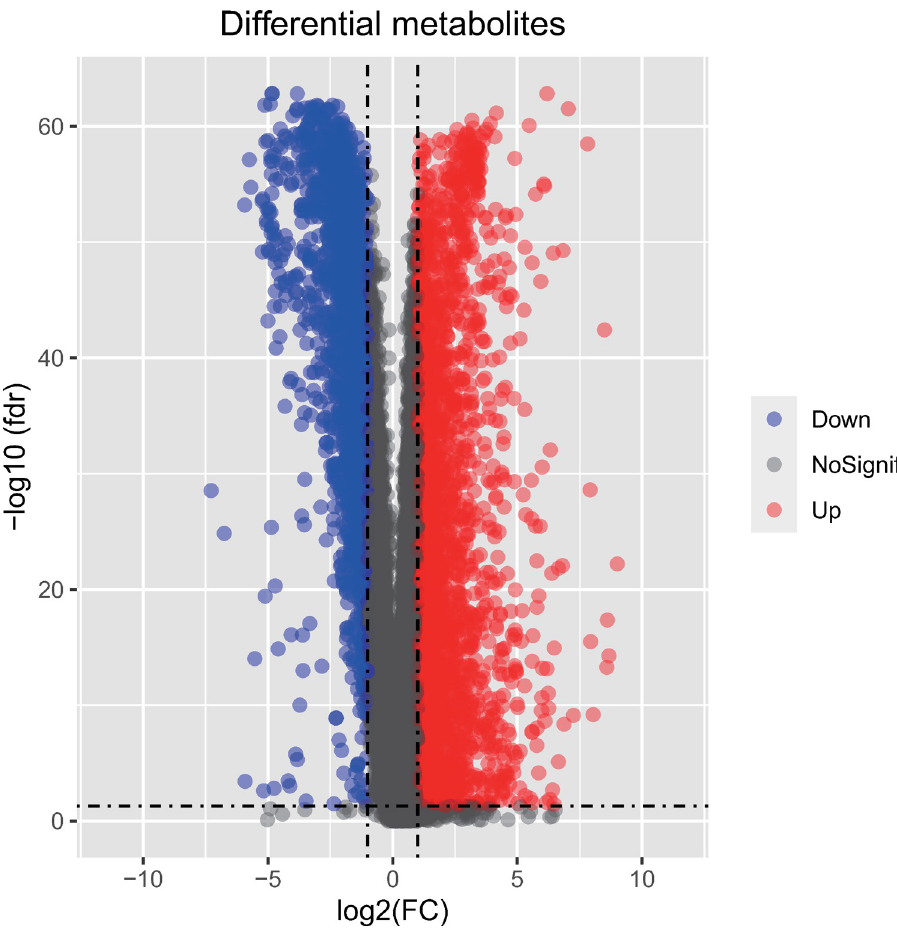
Fig 3. Volcano plot of differentially expressed genes. The red and blue dots represent upregulated and downregulated genes, respectively.